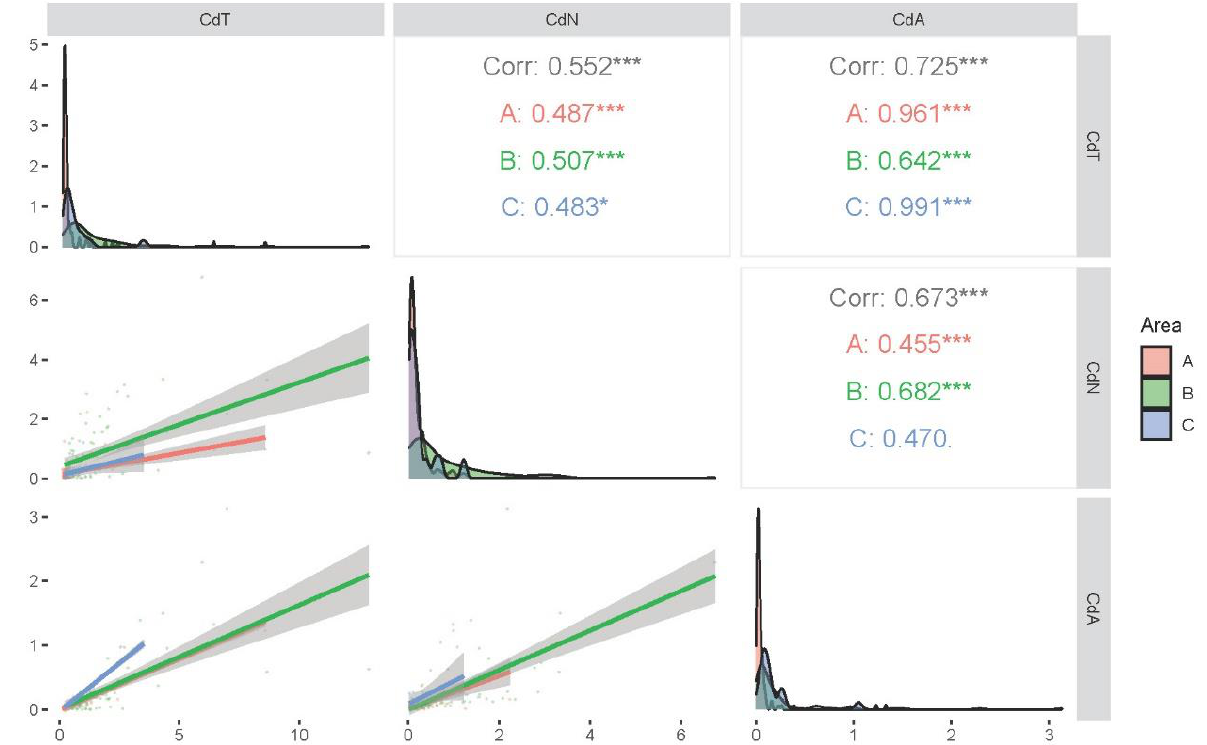
Figure 2. Correlation between Cd content in a soil – rice system (significance codes, ***: P < 0.001, *: P ≤ 0.05 ).